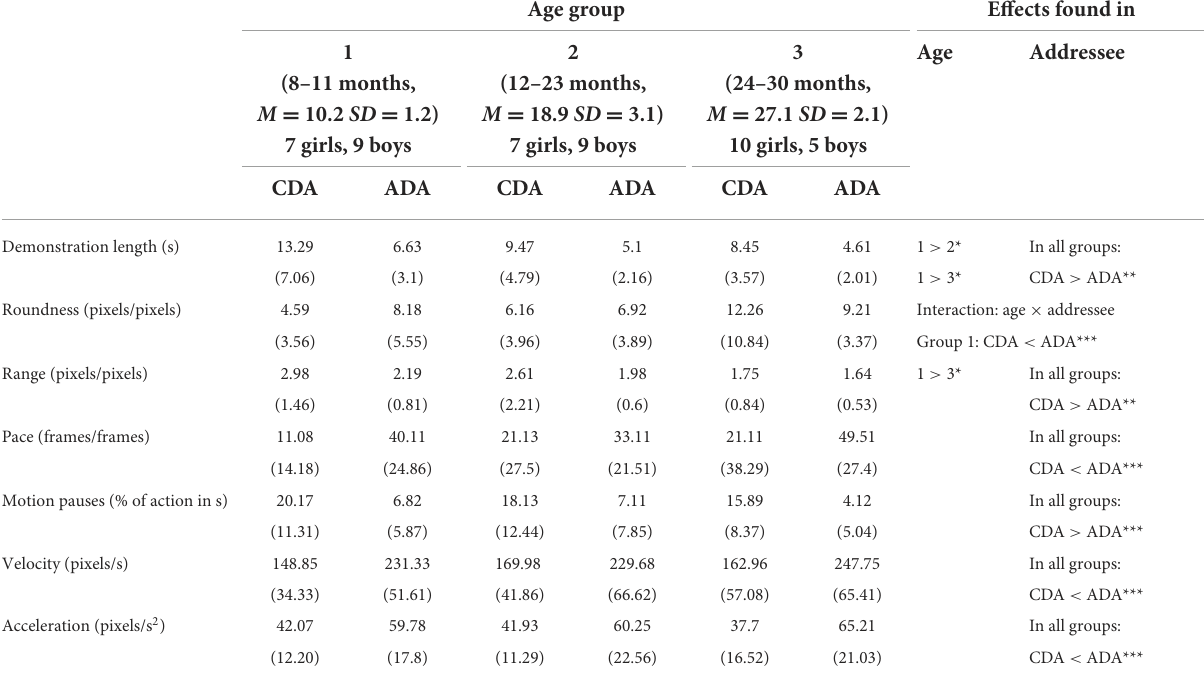
TABLE 2 Results from Study 1 along the parameters for action modifications conveying means, SDs , and significant effects ( * p < 0.05, ** p < 0.01, *** p <